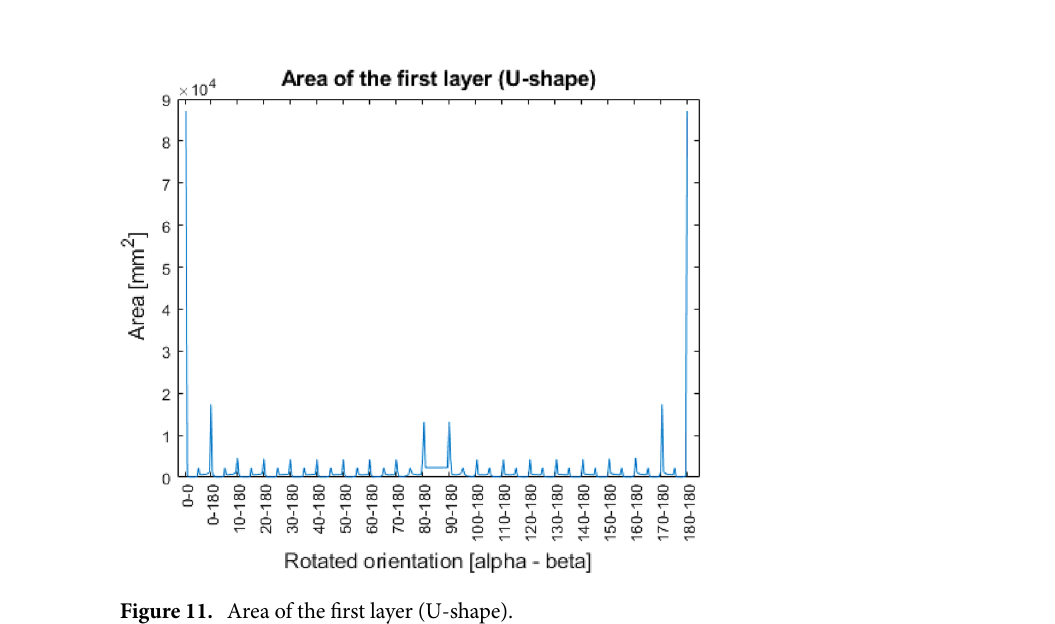
Figure 10. Area of the first layer (Sphere).